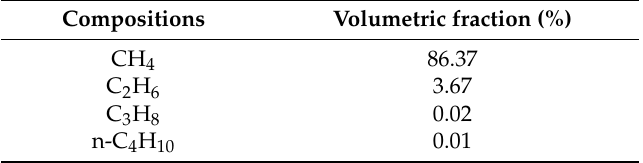
Table 3. Compositions of the employed compressed natural gas (CNG)